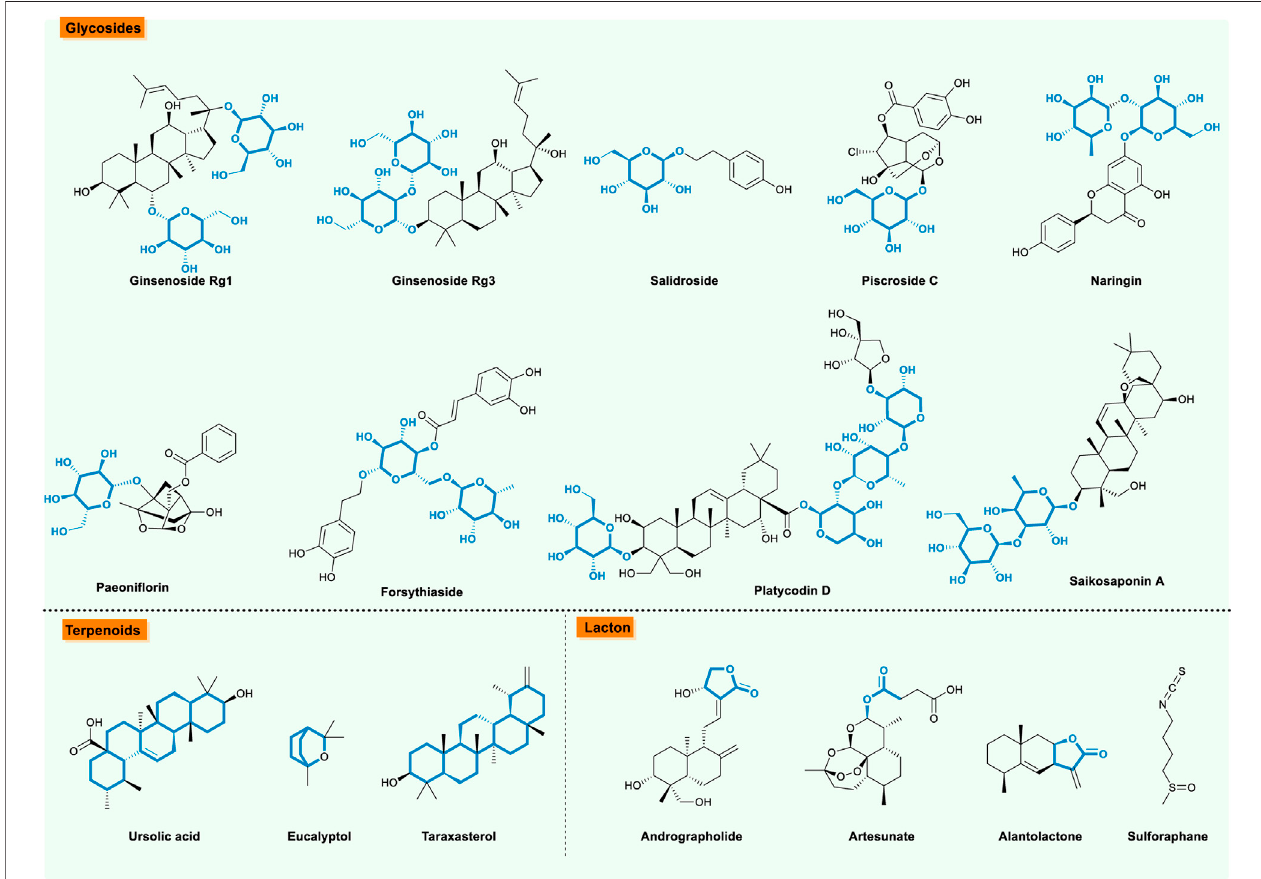
FIGURE 5 | The bioactive natural compounds from glycosides, terpenoids, and lacton.